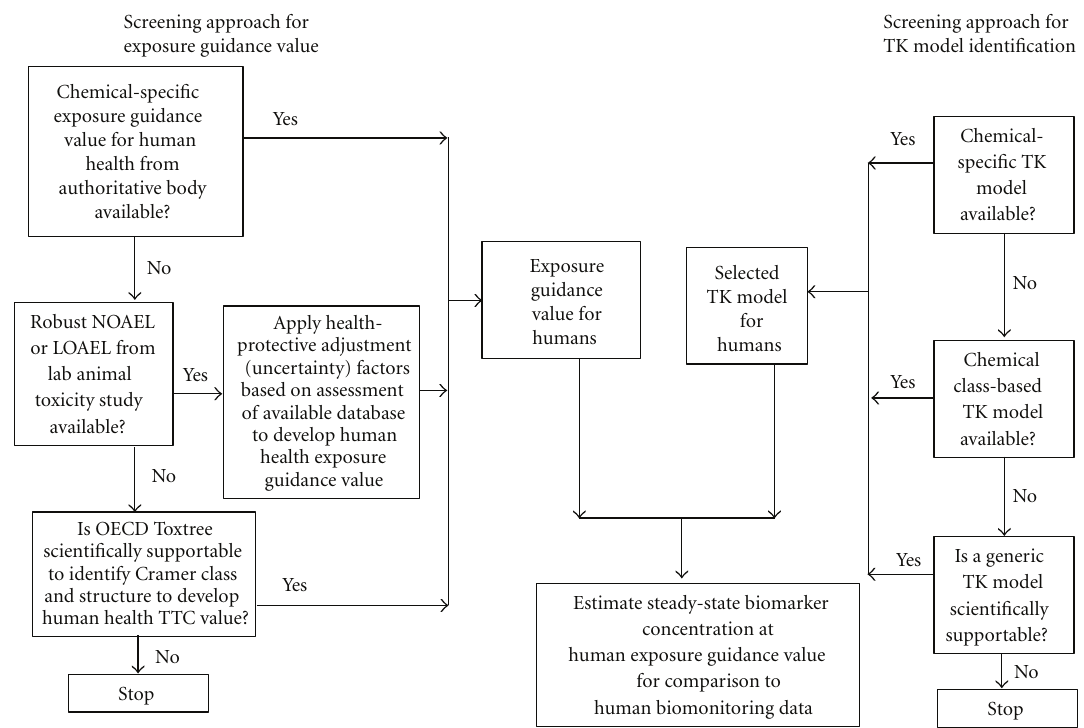
Figure 1: Flowchart showing approaches for development of screening values for assessment of biomonitoring data for chemicals with varying levels of available data on both hazard and